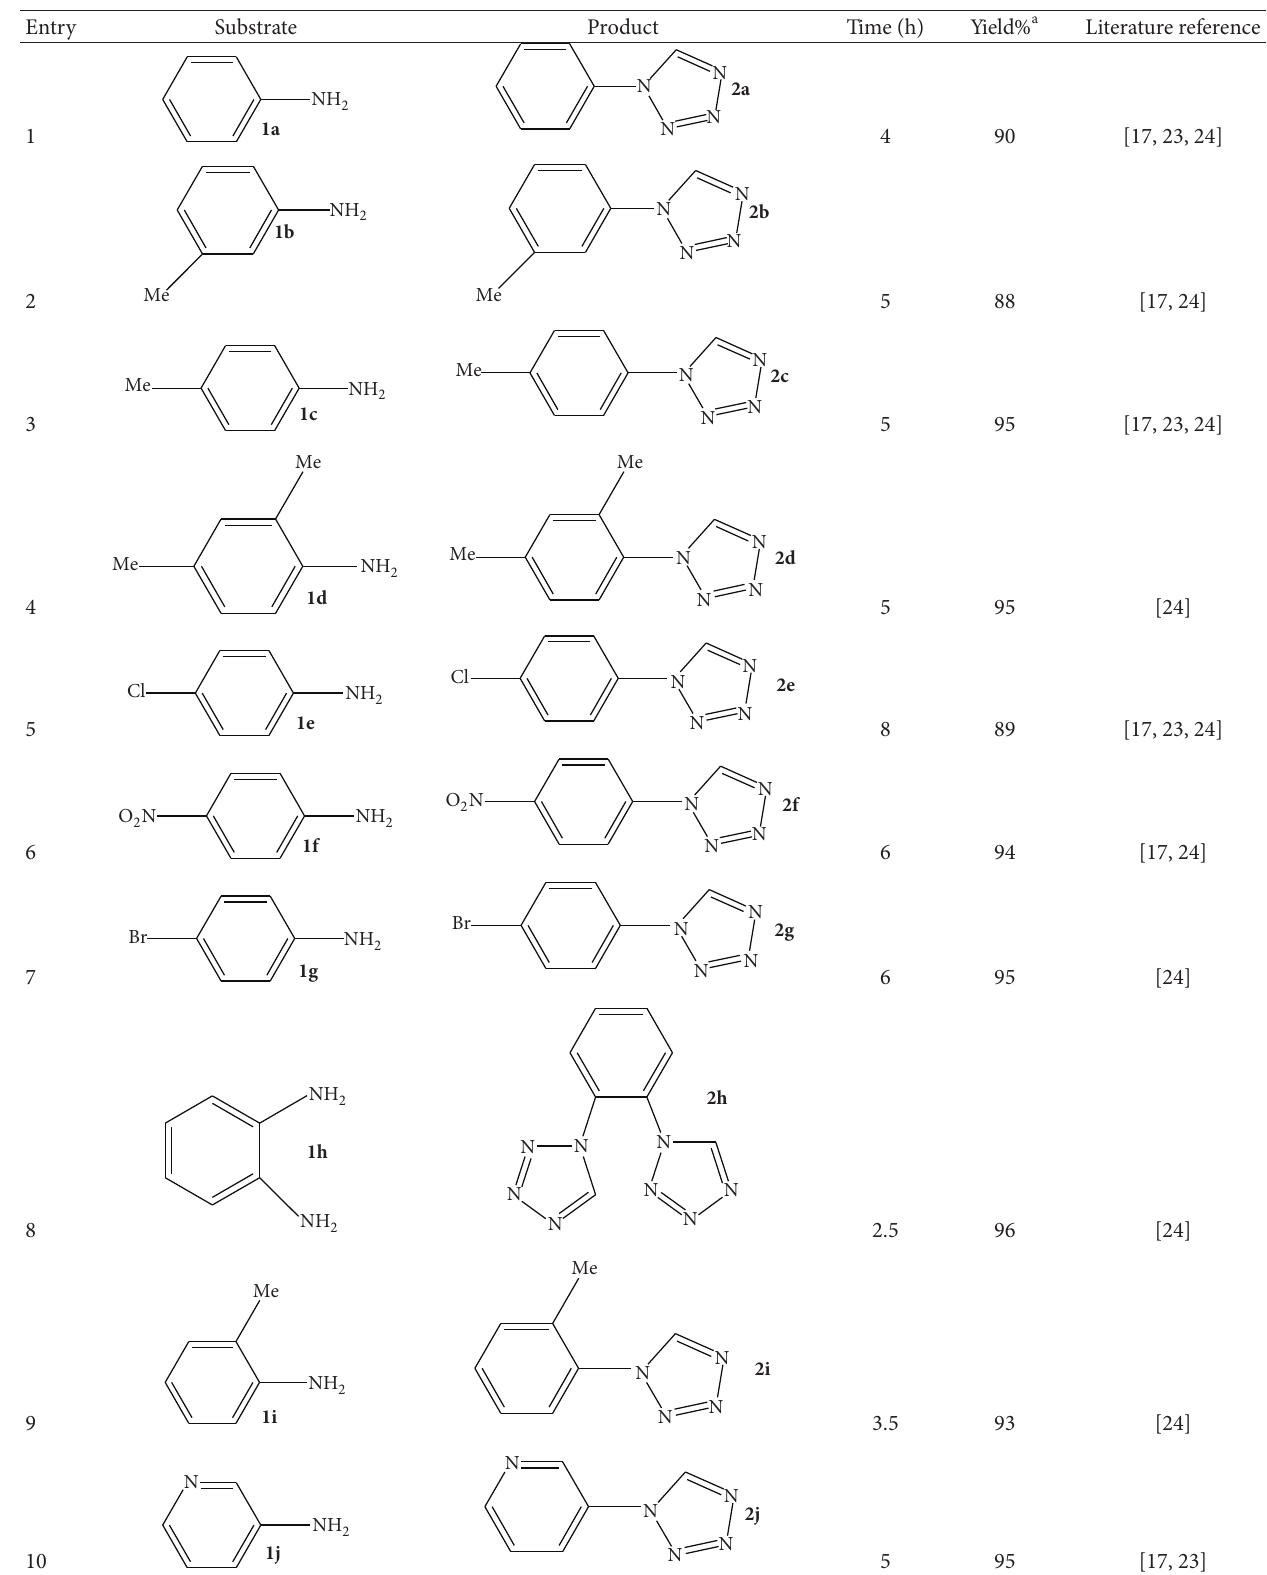
T 1: Synthesis of 1-substituted 1H-1,2,3,4-tetrazoles from the reaction of primary amines, sodium azide, and triethyl orthoformate in the presence of SSA at